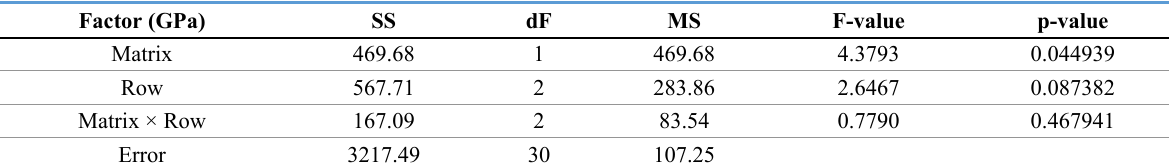
Table 1. ANOVA for elastic modulus (GPa).